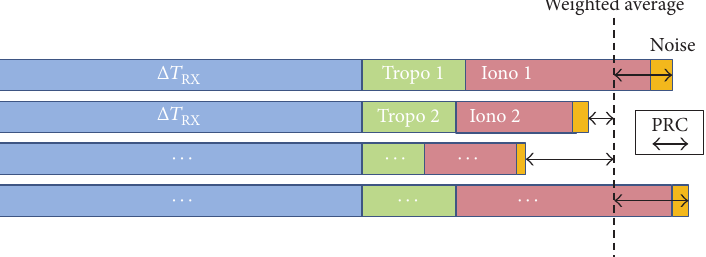
Figure 1: Illustration of the receiver clock adjustment process in the generation of pseudorange corrections